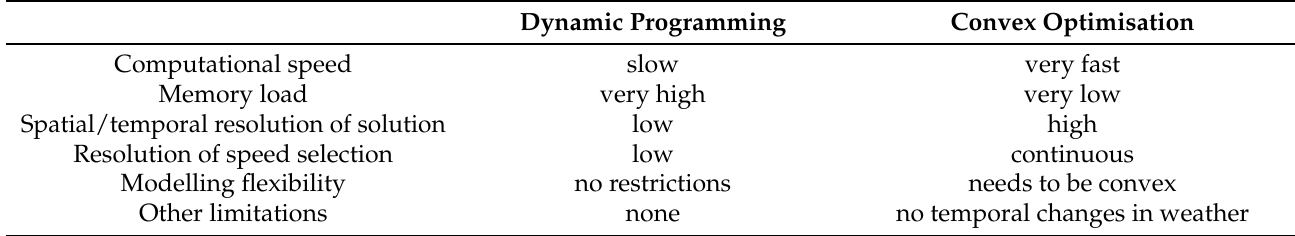
Table 1. Dynamic programming vs. convex